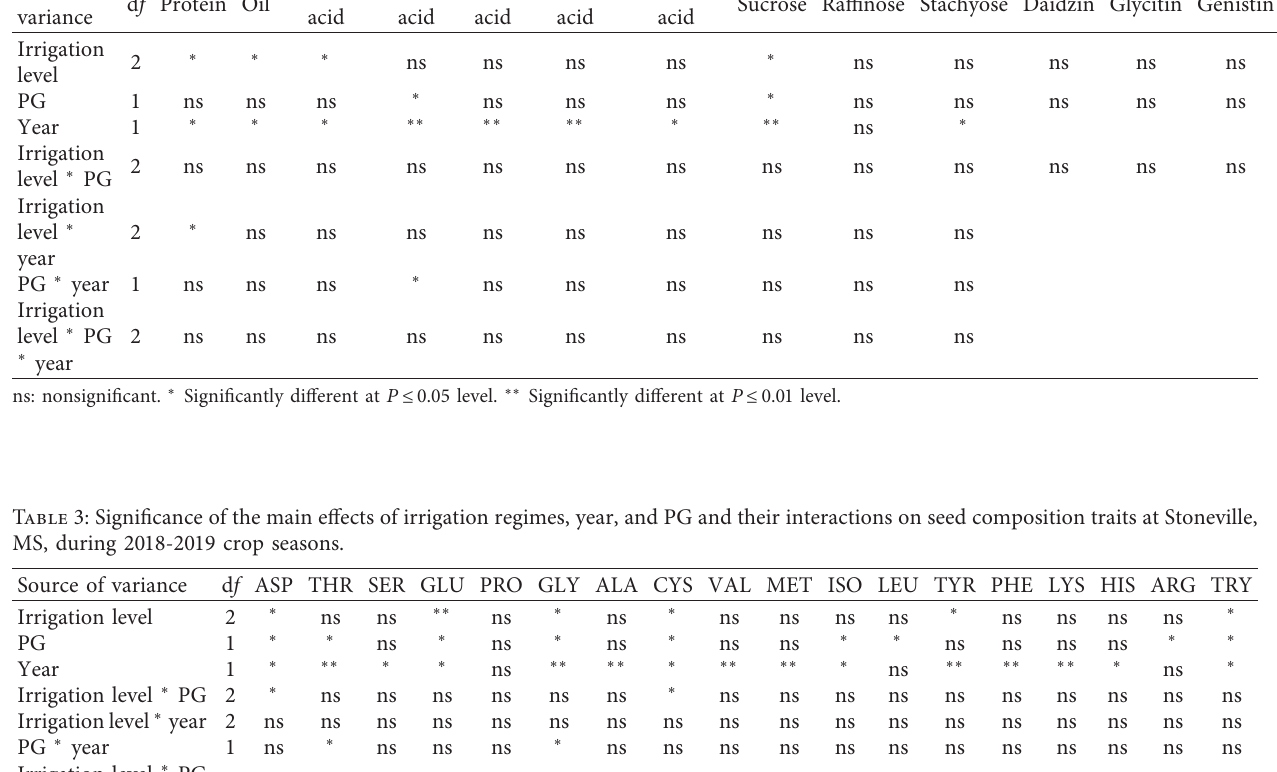
Table 2: Significance of the main effects of irrigation regimes, year, and planting geometry (PG) and their interactions on seed composition traits at Stoneville, MS, during 2018-2019 crop seasons. Source of variance